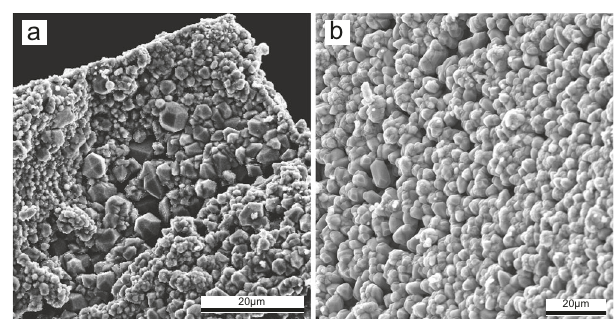
Fig. 2 Secondary electron image of the sample surface. Magnetite grains replaced by hematite, for reactions in oxidant-free conditions and in the presence of either a Ce(III) or b Nd(III) in solution. In a , recrystallized hematite shows signi fi cant variance in crystal sizes, whereas in b , crystal sizes are statistics (e.g. crystal morphology and size distribution) for